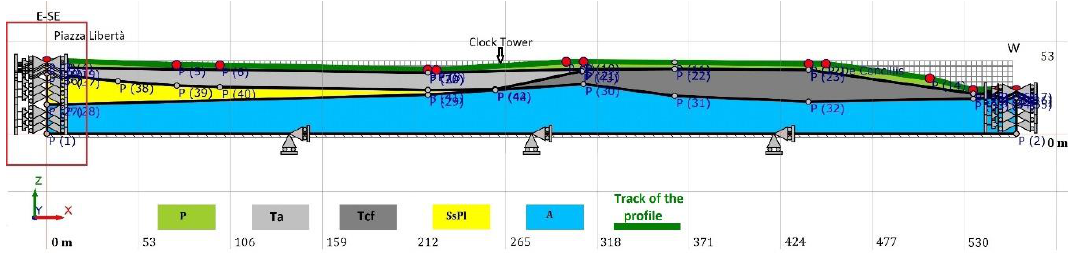
Figure 8. Subsoil model adopted for the 2D ground response analysis. The red box highlights the damped conditions imposed at the lateral boundaries. Mechanical and dynamic lithotypes parameters are reported in Table 5.